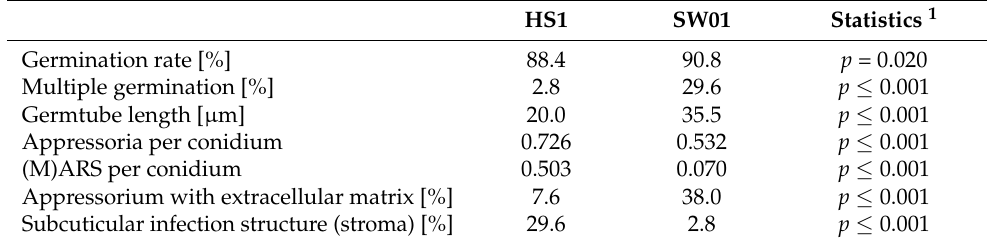
Table 3. Development of Venturia inaequalis isolates HS1 (wild type) and SW01 (melanin-deficient) on apple leaves, 96 h p.i. Mean ± standard error of the mean (n = 307).